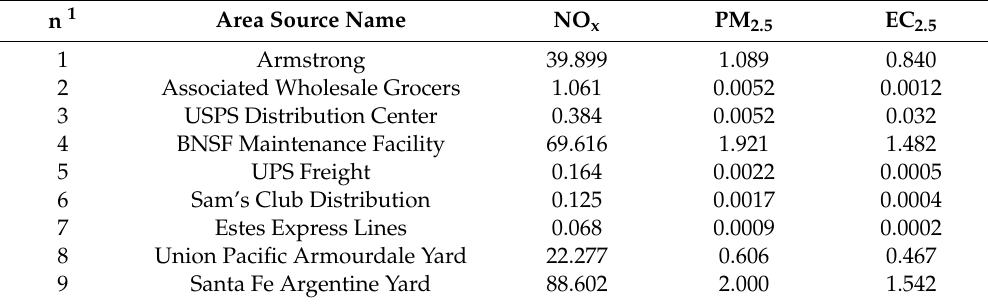
Table 2. Emissions [tons / year] for nine large area sources were